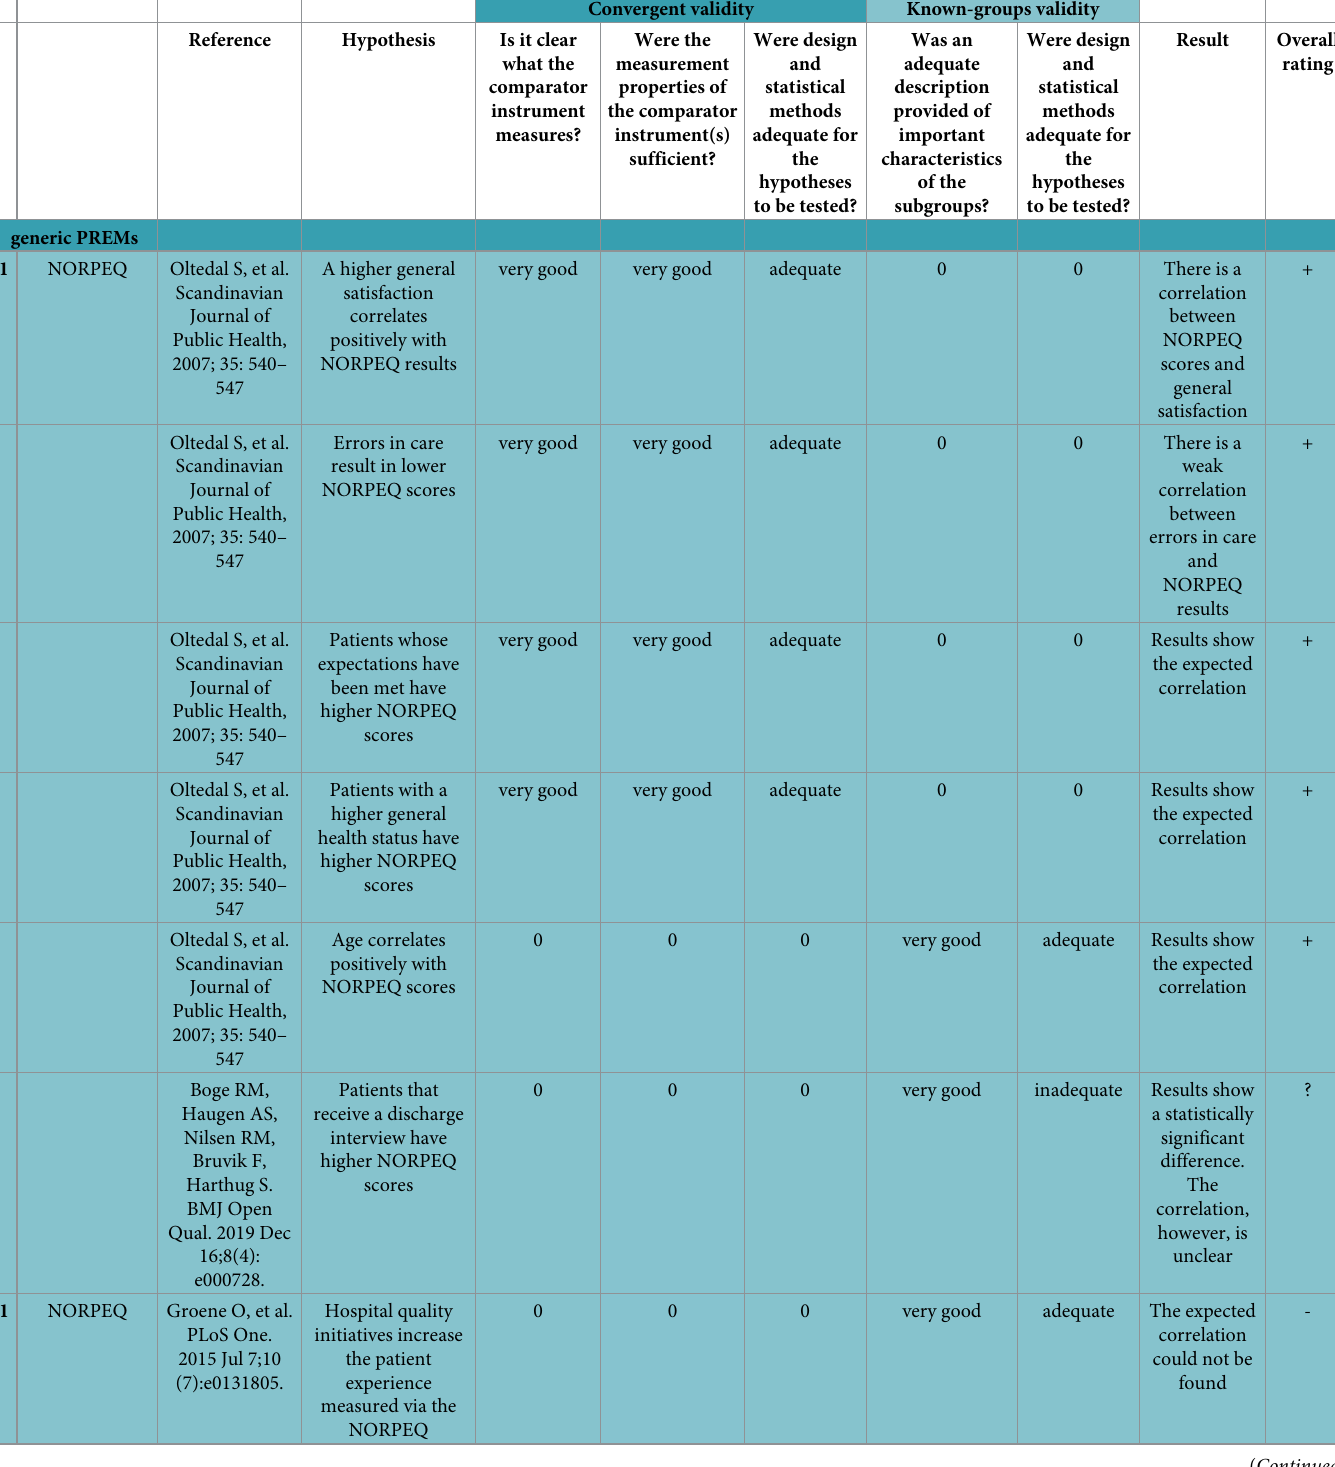
Table 10. Results of hypothesis testing for construct validity of German-language PREMs. Rating according to COSMIN